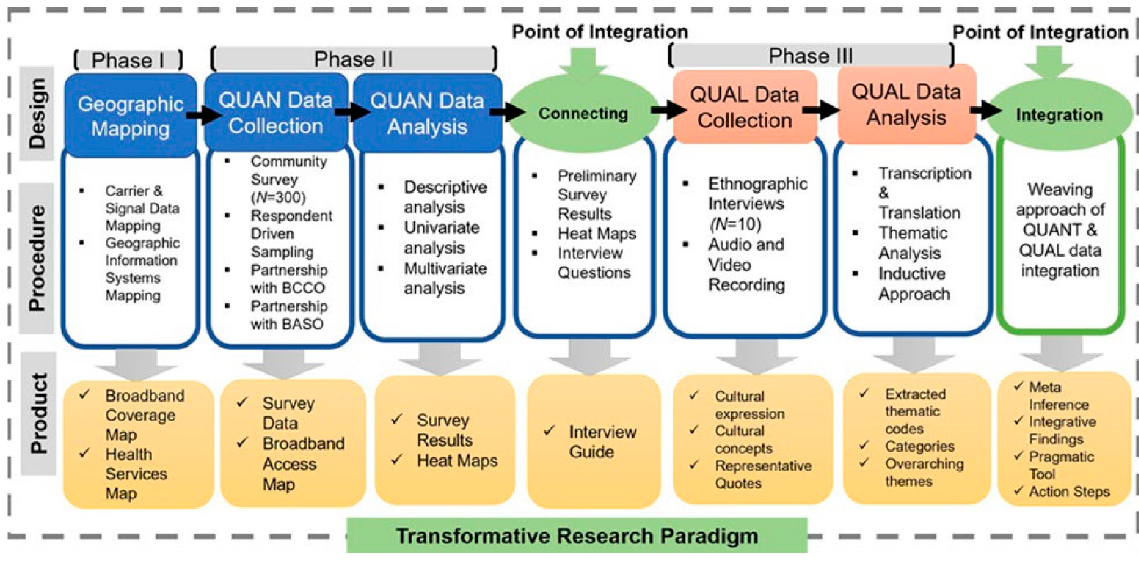
Figure 1. Transformative Research Paradigm.